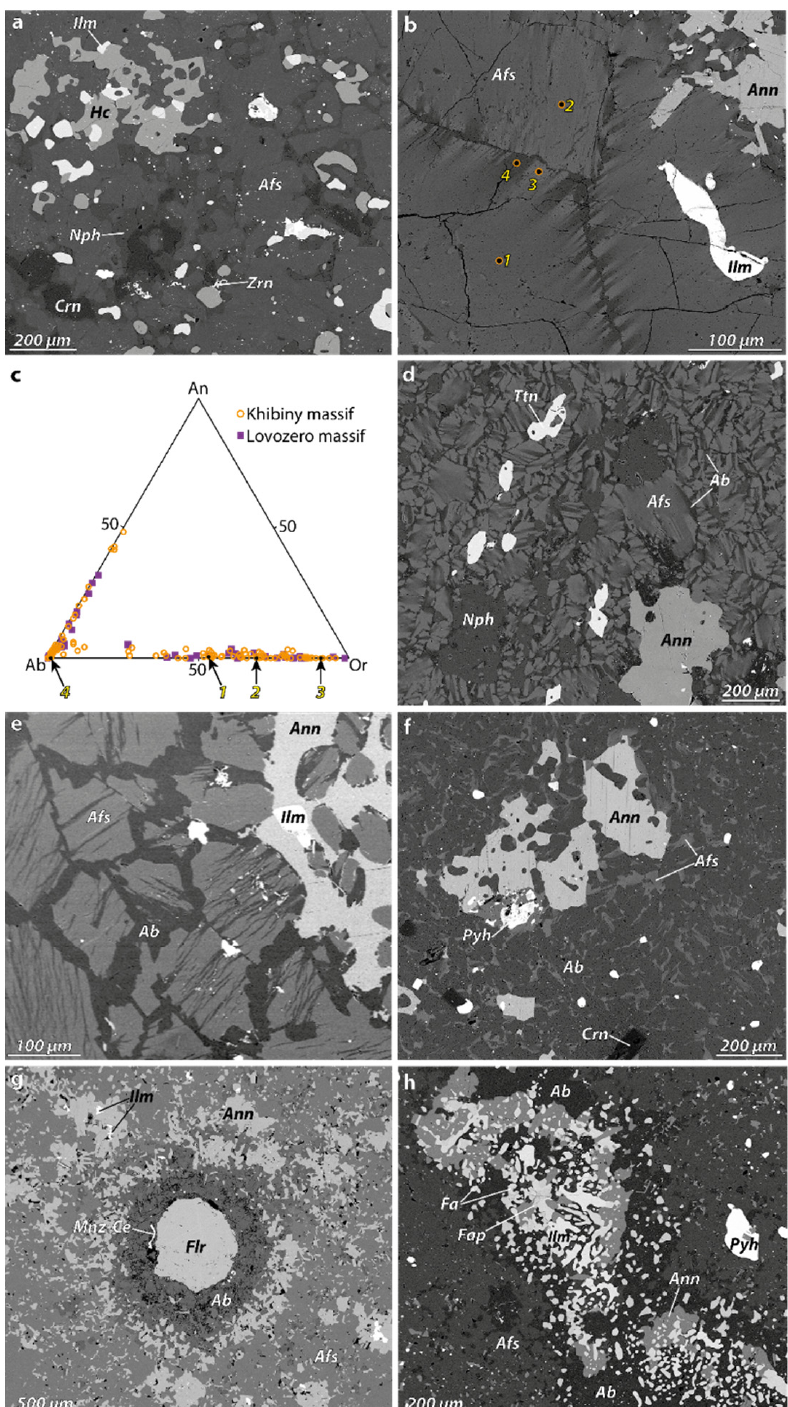
Figure 6. Morphology and chemical composition of feldspars from aluminous hornfels. ( a ) homo- geneous (K,Na)-feldspar grains (sample M-01-2-8); ( b ) beginning of (K,Na)-feldspar albitization; flame perthites are formed at the grain boundaries (sample KCH-05-13); ( c ) albite (Ab)–orthoclase (Or)–anorthite (An) ternary feldspar diagram. The points with numbers (1–4) correspond to the points in ( b ); ( d ) intensely albitized (K,Na)-feldspar (sample LV-122); ( e , f ) (K,Na)-feldspar relics in albite (samples KH-61-11 and KCH-05-31, respectively); ( g ) albite (Ab 51 An 48 Or 1 ) rims around a fluorite grain (sample M-01-2-4); ( h ) albite (Ab 58 An 42 ) rims around the segregations of dark-colored (annite+ilmenite) minerals (sample M-01-3). BSE-images ( a , b , d – h